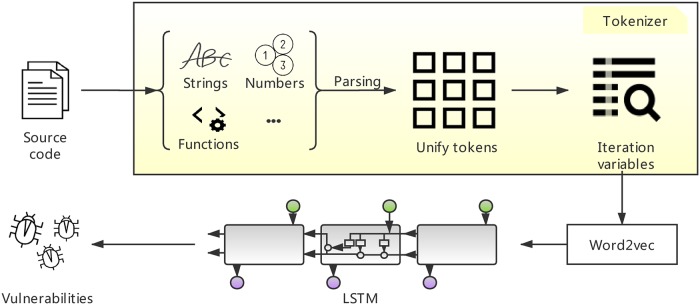
Overview of TAP.